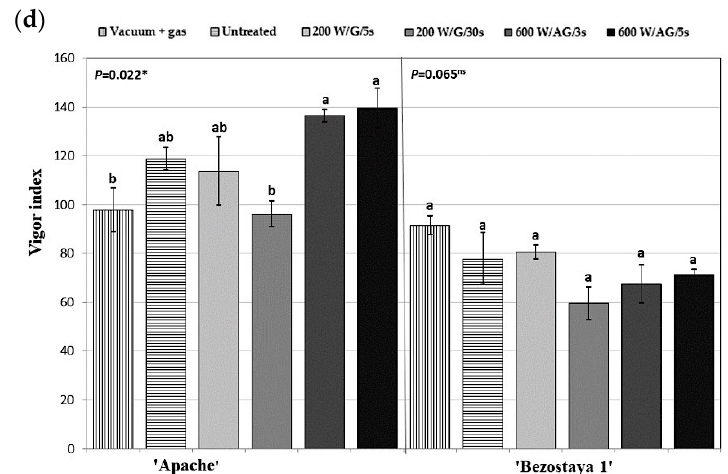
Figure 3. The number of roots per plant ( a ), root system length ( b ), seedling fresh weight ( c ), and seed vigor ( d ) of two wheat varieties depending on seed treatment with oxygen plasma at different treatment conditions. The displayed values are the mean ± SEM of three replications. The different letters (a–c) indicate statistically significant differences among treatments according to Duncan’s test ( α = 0.05). Non-significant differences are marked as “ns”.